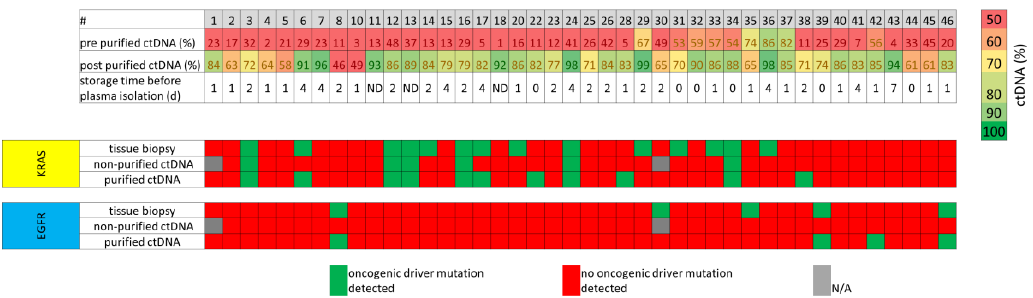
Figure 6. Improved sensitivity of oncogenic gene mutations in rescued plasma DNA samples. CtDNA content pre and post purification as well as duration to plasma preparation was shown for each sample. DNA was purified up to 44–99% with a mean of 77% ctDNA. Comparison of resequencing analyses using tumor tissue samples, non-purified plasma DNA samples (pre purified ctDNA) and purified DNA samples (post purified ctDNA) of 42 patients with non-small cell lung cancer (NSCLC) with an eight-gene panel including EGFR, KRAS, IDH1, IDH2, PDGFRA, NRAS, BRAF and KIT . Samples with oncogenic mutations in KRAS (middle part) or EGFR (lower part) are labeled green, all samples without driver mutations were labeled red (ND = not documented; N/A = not available).